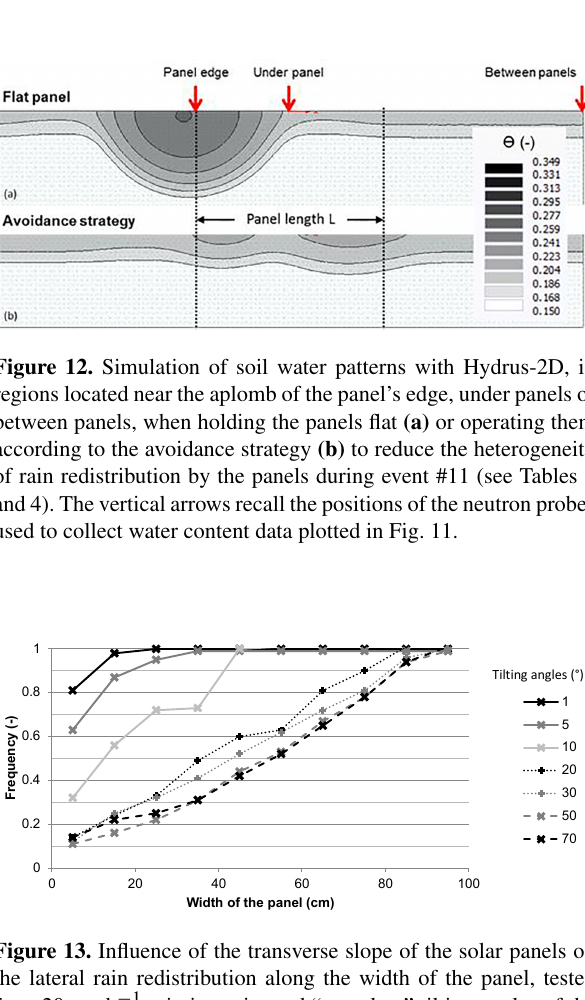
Figure 10. Influence of the structure parameters (spacing E , length L ) of the panels on the spatial heterogeneity of rain redistribution from the simulated values of the coefficient of variation (Cv) for panels held flat (a) or operated according to the avoidance strategy (b) . The combinations of E and L values may be assimilated to equivalent 1D surface coverage between 20 and 60% by dividing L by E . Only the realistic combinations have been simulated here: blank cells indicate those that are not.